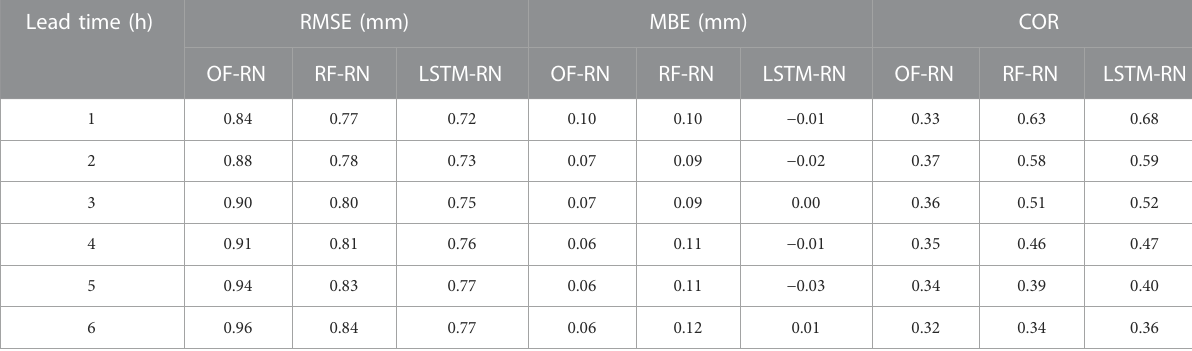
TABLE 4 RMSE, MBE, and COR of three types of models at different lead times. Lead time